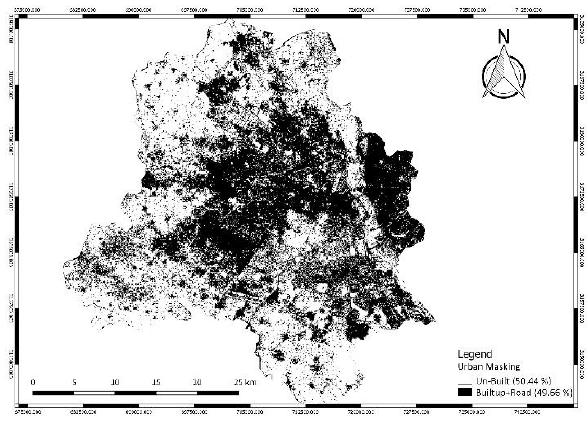
Figure 7 . Urban Mask over study